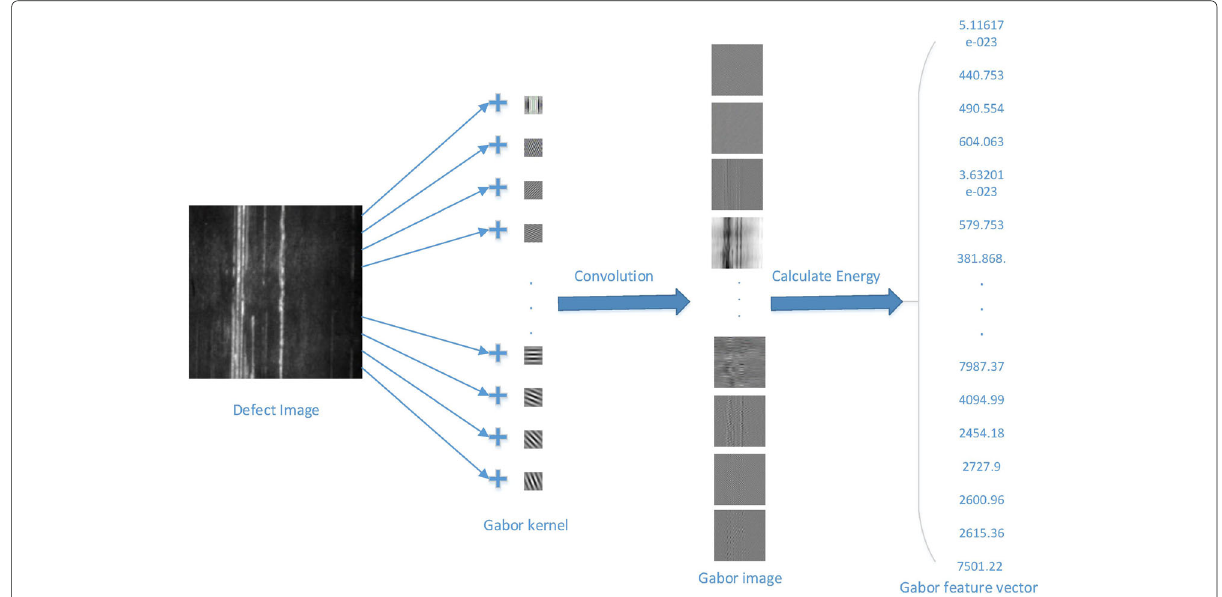
Fig. 5 Process to convert defect image to Gabor feature